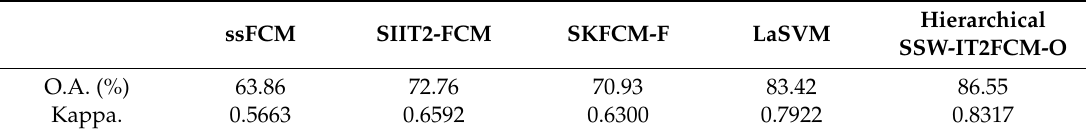
Figure 15. Classification results of five methods when the sample size was reduced to 8%. Table 8. The overall accuracies and Kappa coefficients produced by the five methods if the sample size is reduced to 8%.